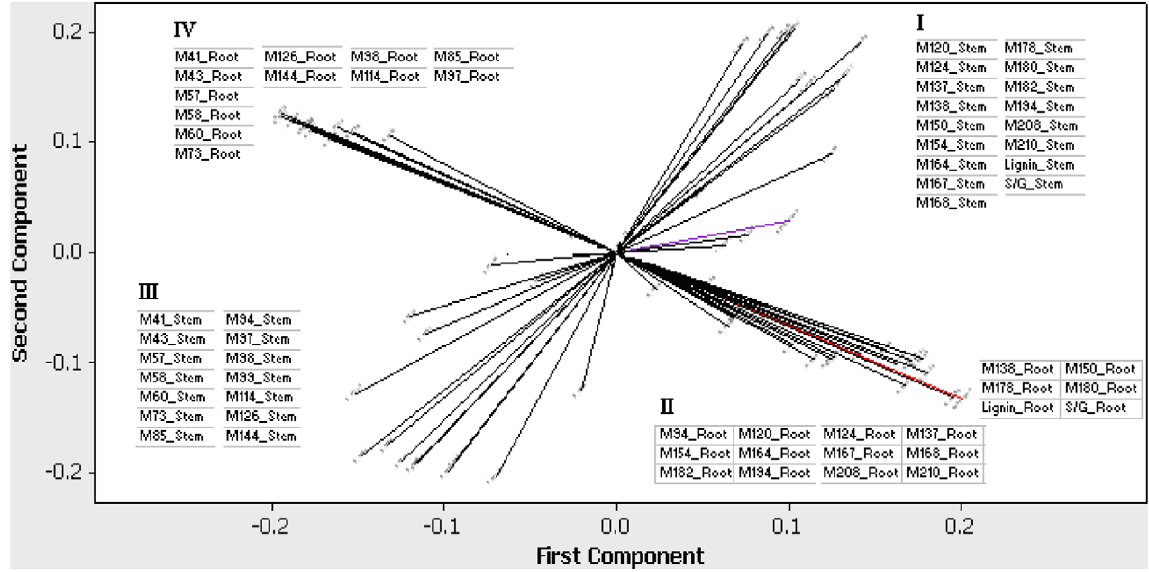
Figure 1. Principal component analysis for all the quantified traits. Note: correlation loadings were plotted for the first two principal components. The red line represents root lignin and the purple represents stem lignin. Subcomponents within each cluster are positively correlated, by contrast, subcomponents in opposite clusters are negatively correlated (e.g., cluster I vs. cluster III, and cluster II vs. cluster IV).